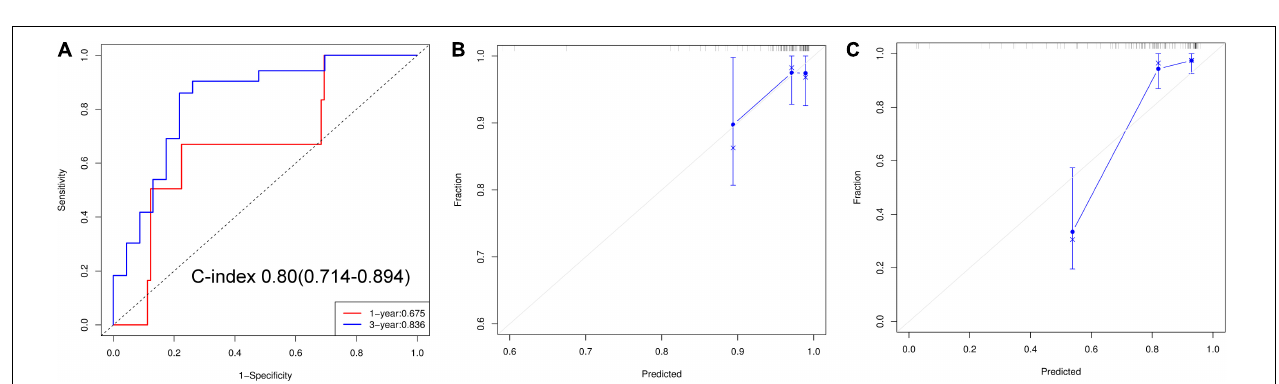
FIGURE 6 | (A) ROC curves of nomogram for predict 1 and 3 years of MACEs risk. (B) Calibration curve for 1-year predict. (C) Calibration curve for 3-year predict.